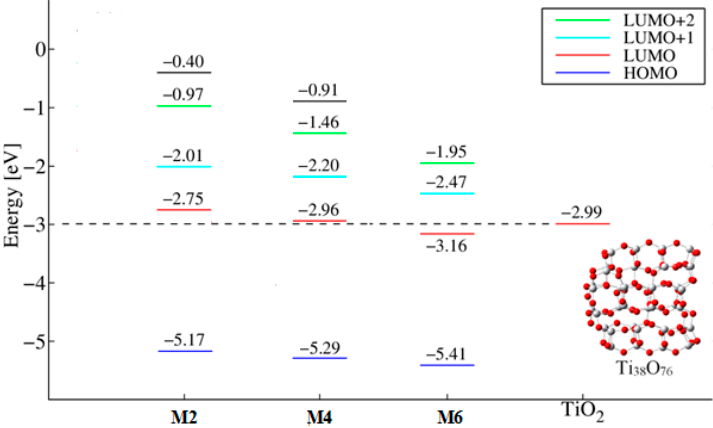
Figure 8. LUMO, LUMO + 1, and LUMO + 2 energy levels of chlorin dyes M2 , M4, and M6 . The values for the conduction band edge of the semiconductor calculated from a Ti 38 O 76 cluster is added for comparison (dashed line).